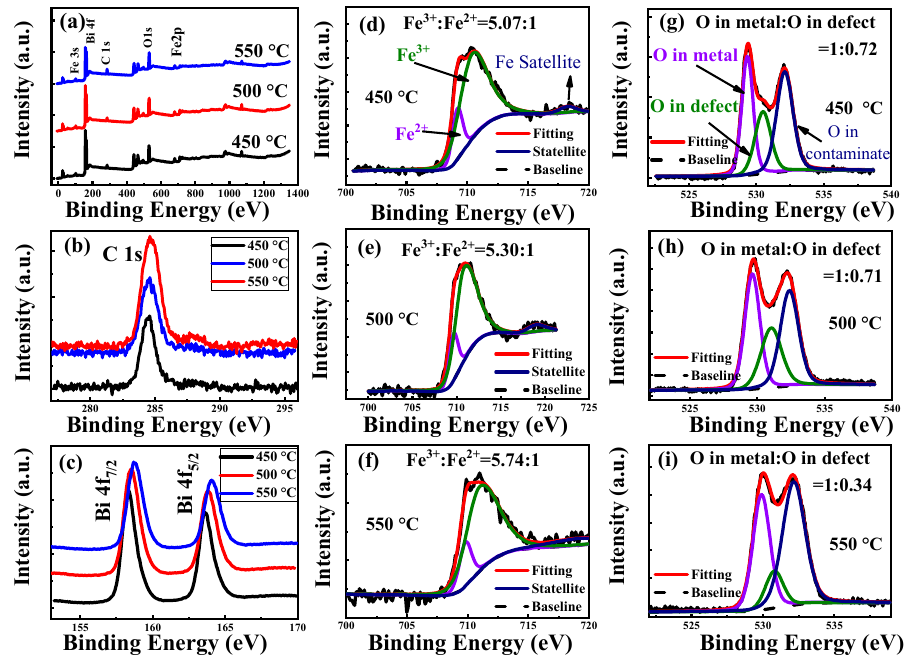
Figure 4. Wide-scan XPS spectra ( a ), narrow-scan XPS spectra of ( b ) C 1s, ( c ) Bi 4f of BFO films, narrow-scan XPS spectra of ( d ) Fe 2p 3 / 2 , 450 ◦ C, ( e ) Fe 2p 3 / 2 , 500 ◦ C, ( f ) Fe 2p 3 / 2 , 550 ◦ C, ( g ) O 1s, 450 ◦ C, ( h ) O1s, 500 ◦ C and ( i ) O 1s, 550 ◦ C annealed BFO films.